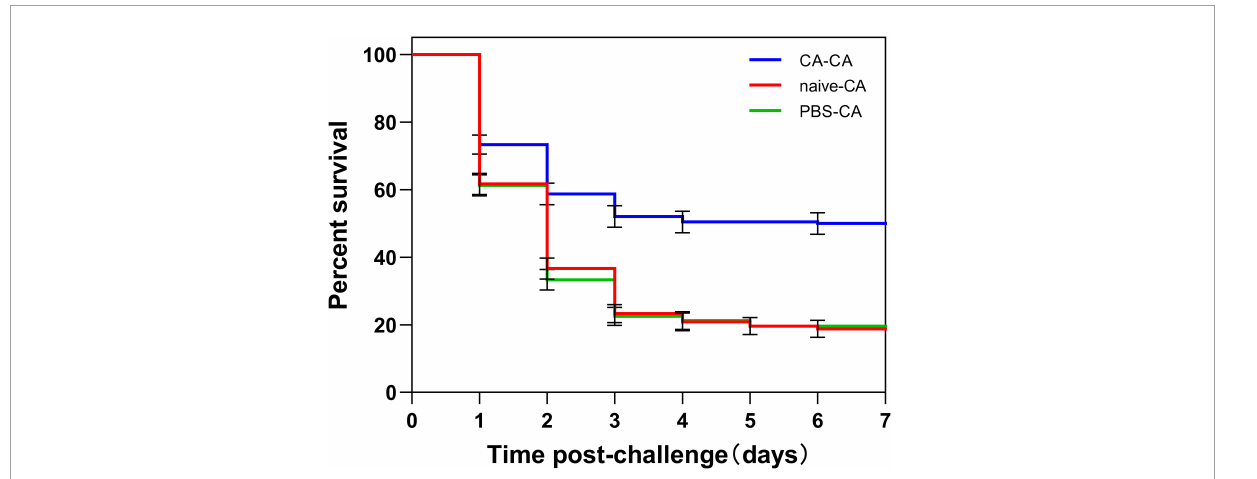
FIGURE3 Survival of housefly adults after challenge. Adults were first primed by injection of heat-killed C. albicans (CA) or injection of PBS as injury control (PBS), or left untreated (naive), then adults challenged with a lethal dose of C. albicans. The survival data of each condition were generated from three replicates, and each had 80 adults. The survival difference was compared using the Log-rank test of the Kaplan-Meier survival analysis. The results are reported as mean ± SE from three independent experiments.